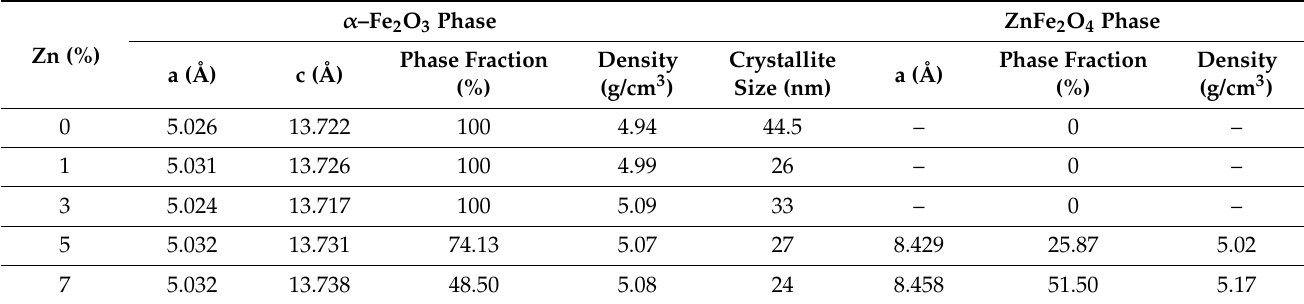
Table 1. Lattice parameters and phase fraction for pure and Zn − doped Fe 2 O 3